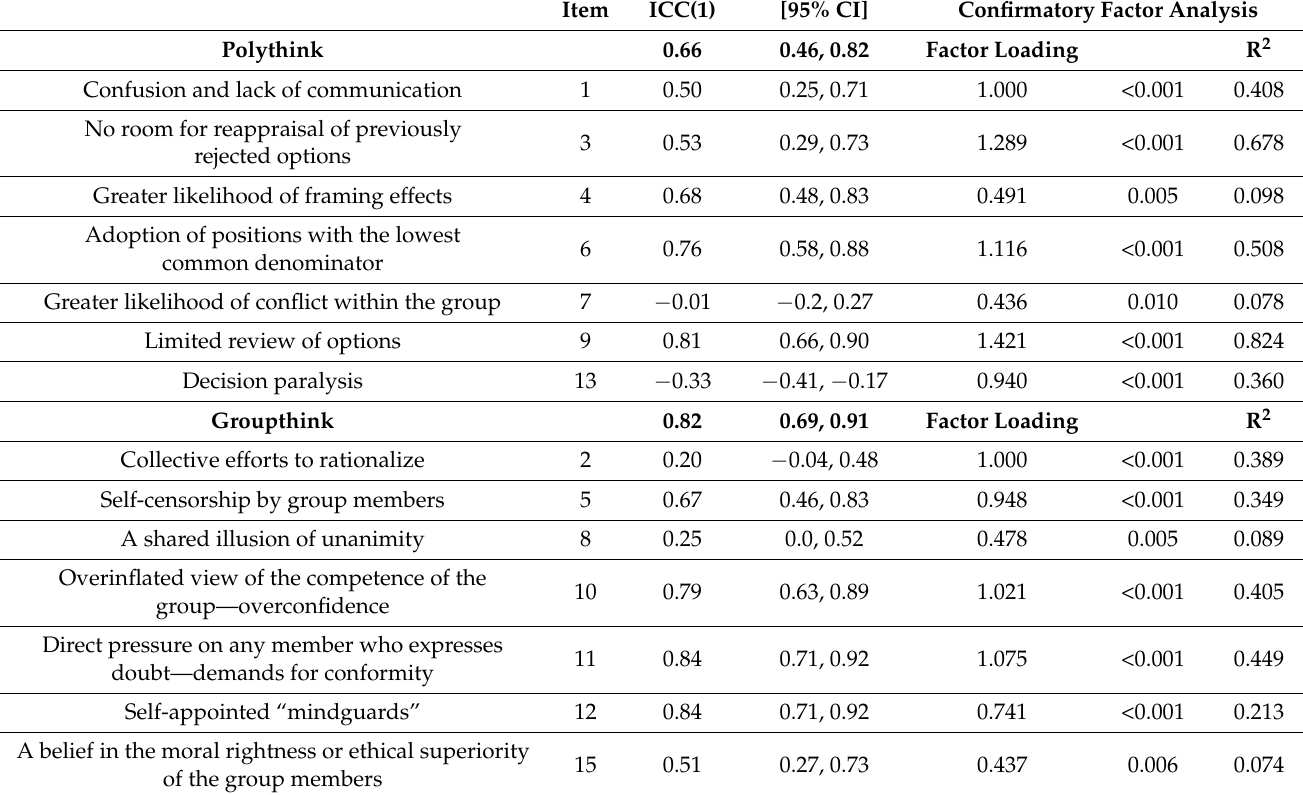
Table 2. Inter-rater agreement and confirmatory factor analysis testing 2-factor model (Polythink and Groupthink) for the items of the assessment tool examining group dynamics in medical